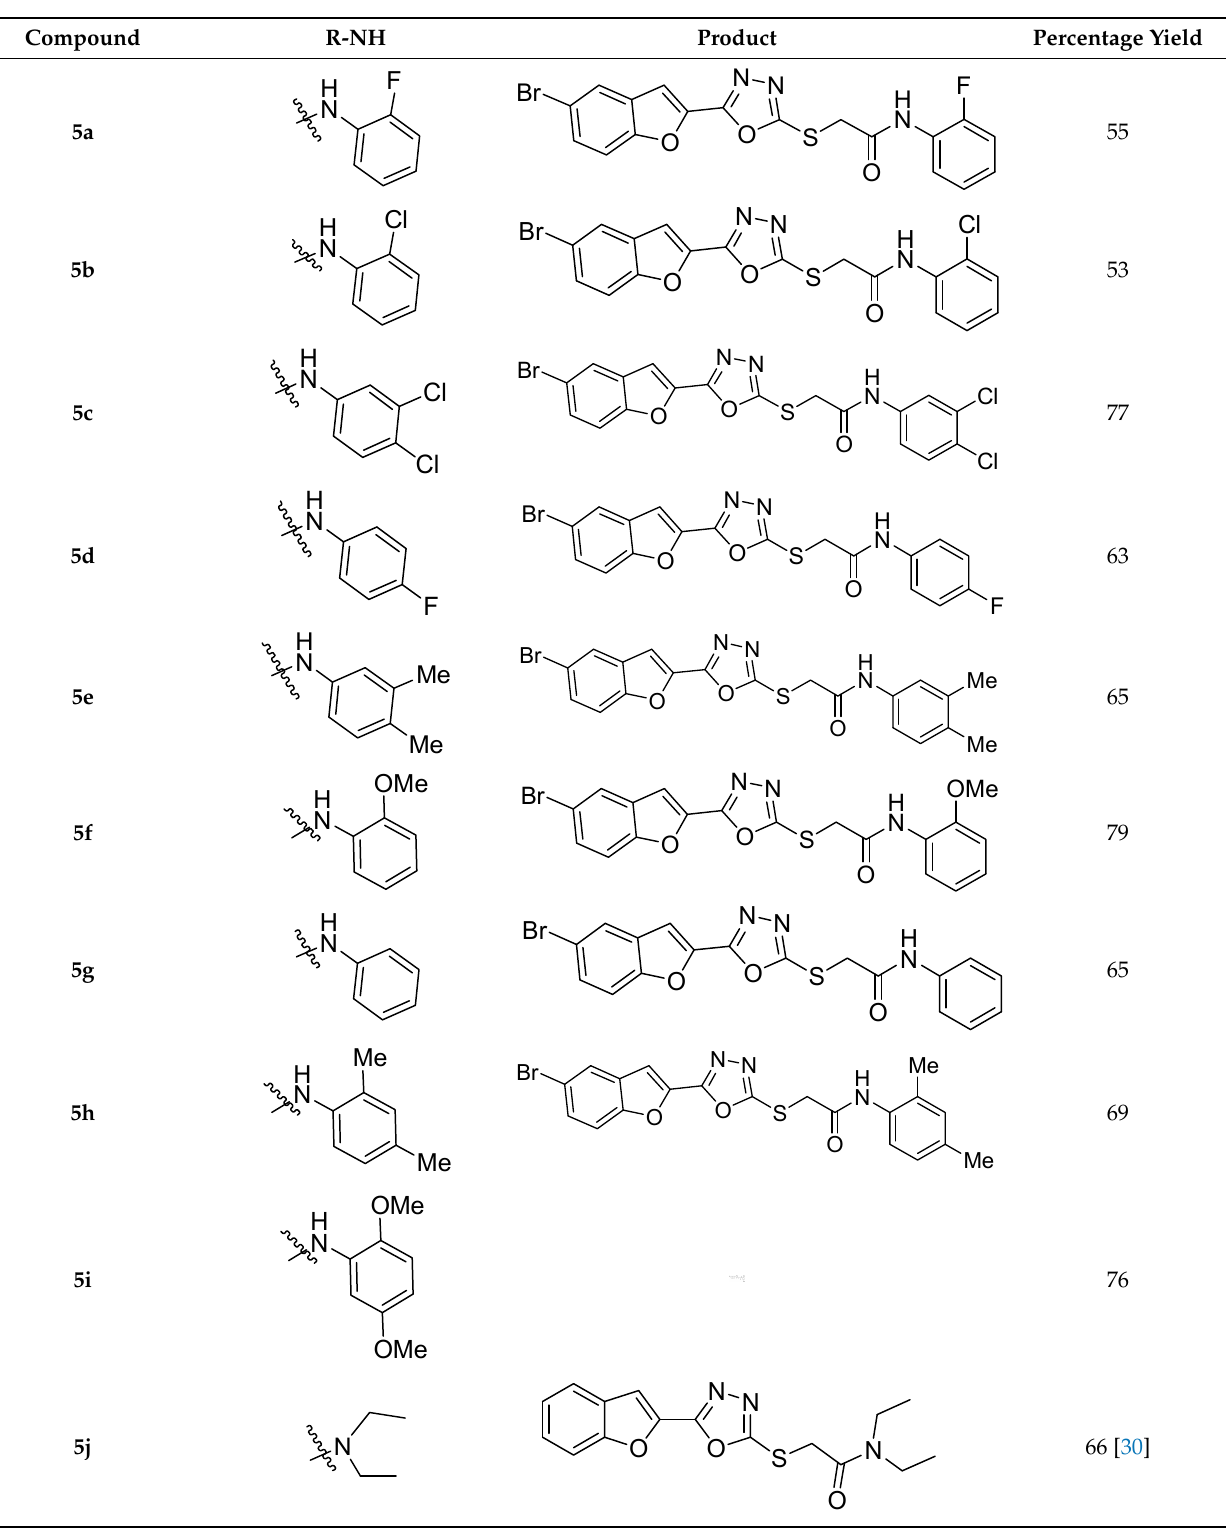
Table 1. Details of synthesis of benzofuran-oxadiazole derivatives 5a–j .